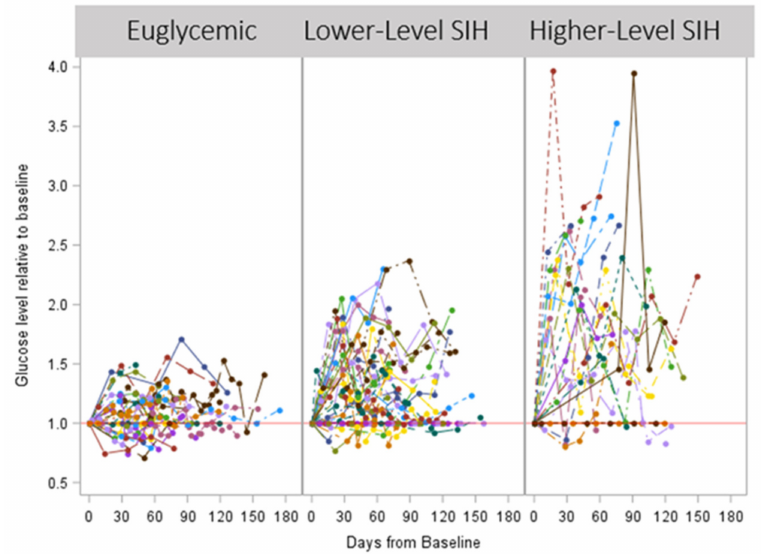
Figure 2. Fluctuations in glucose levels relative to baseline are plotted for euglycemic patients, lower- level SIH patients, and higher-level SIH patients. Spider plot shows the glucose changes for each patient over the course of chemotherapy, with the greatest fluctuations observed in the higher-level SIH patients. Reference line 1 indicates baseline value.